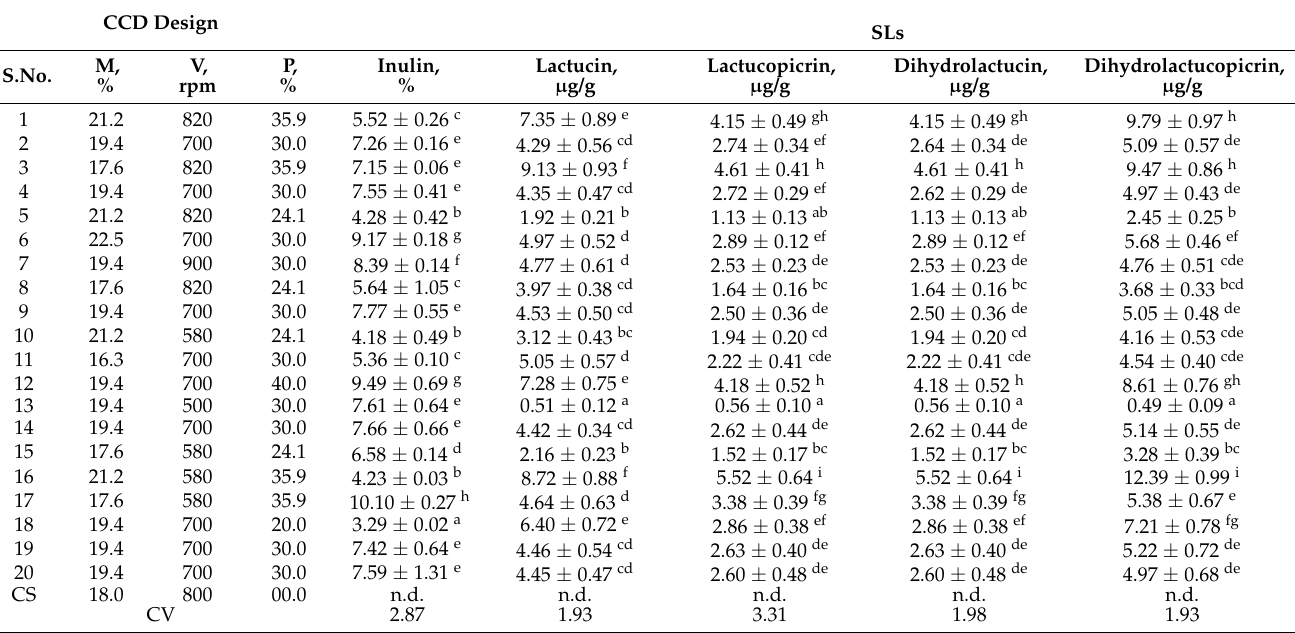
Table 1. Inulin and sesquiterpene lactones (SLs) contents in extrudates and control sample (CS).